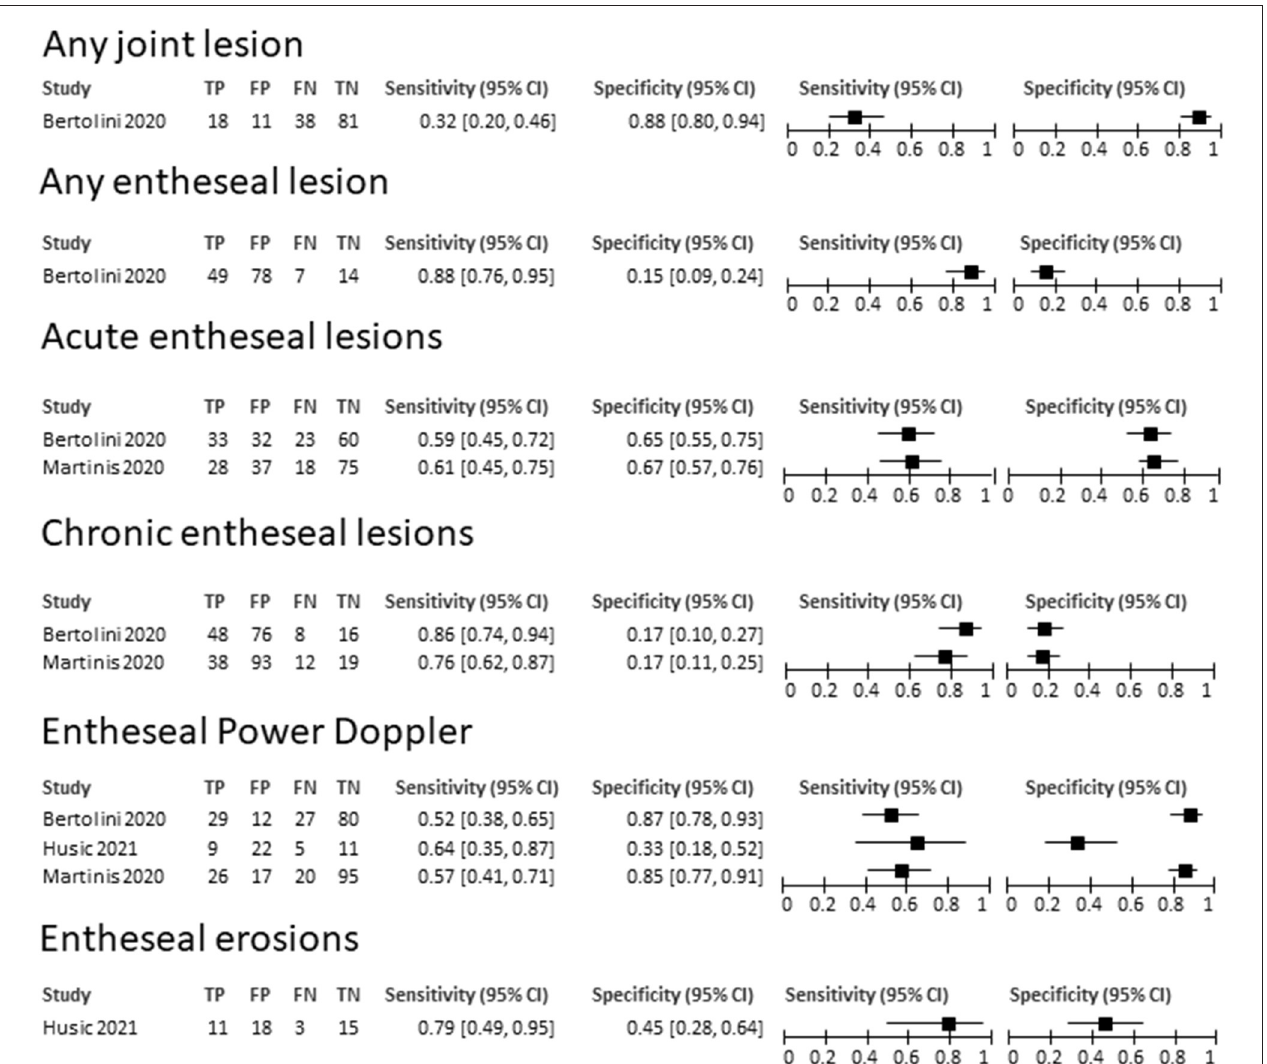
FIGURE 3 | Summary of sensitivities and specificities of ultrasound-detected lesions for a diagnosis of arthritis in patients with IBD. TP, true positive; FP, false positive; FN, false negative; TN, true negative.